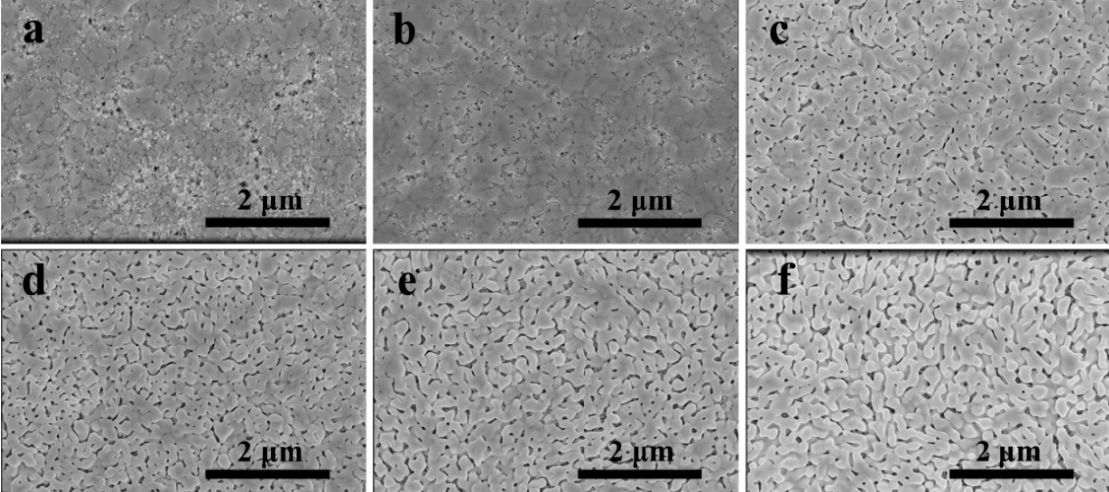
Figure 1. Top-view scanning electron microscope (SEM) images of PbBr 2 films by introducing different concentrations of InBr 3 : ( a ) 0.00 M; ( b ) 0.03 M; ( c ) 0.09 M; ( d ) 0.15 M; ( e ) 0.21 M; ( f ) 0.27 M.